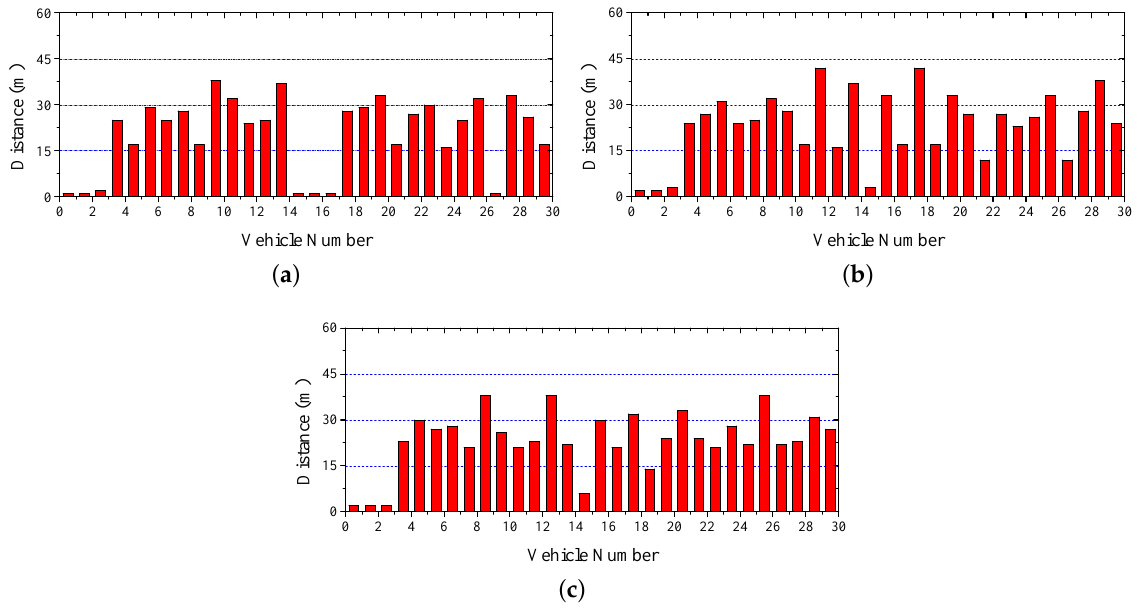
Figure 10. Safety Warning: Distance between two consecutive vehicles. ( a ) IEEE 802.11p; ( b ) VeMAC; ( c )